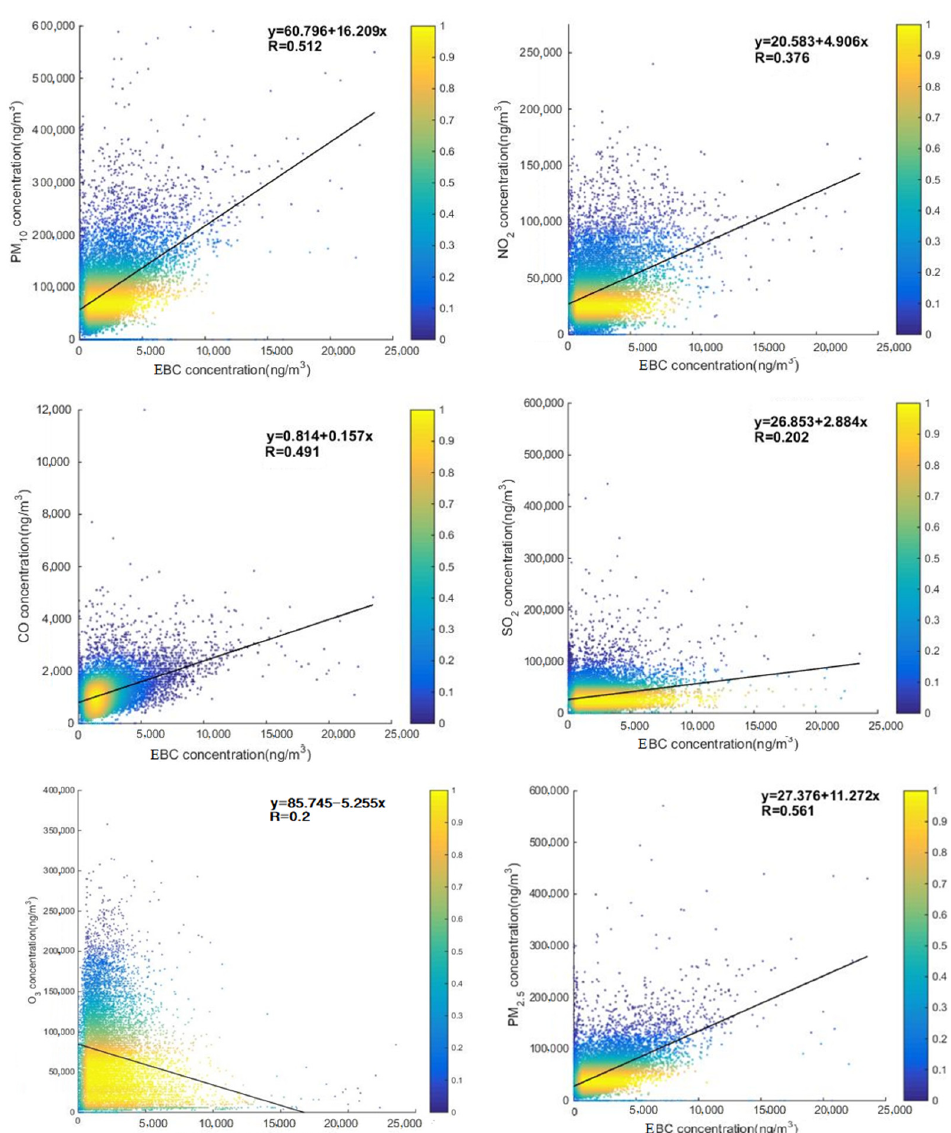
Figure 4. Correlation analysis of equivalent black carbon and atmospheric pollutants. Table 1. Pearson correlation coefficient of multichannel EBC and atmospheric pollutants.